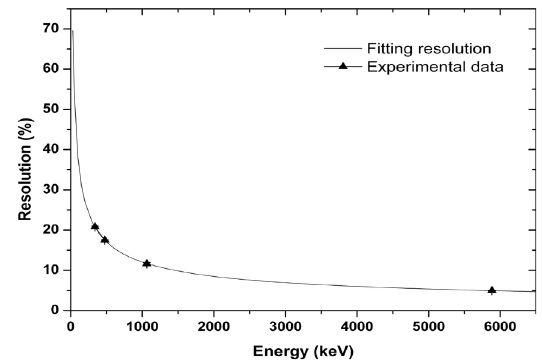
Fig.6 Energy resolution of one C 6 D 6